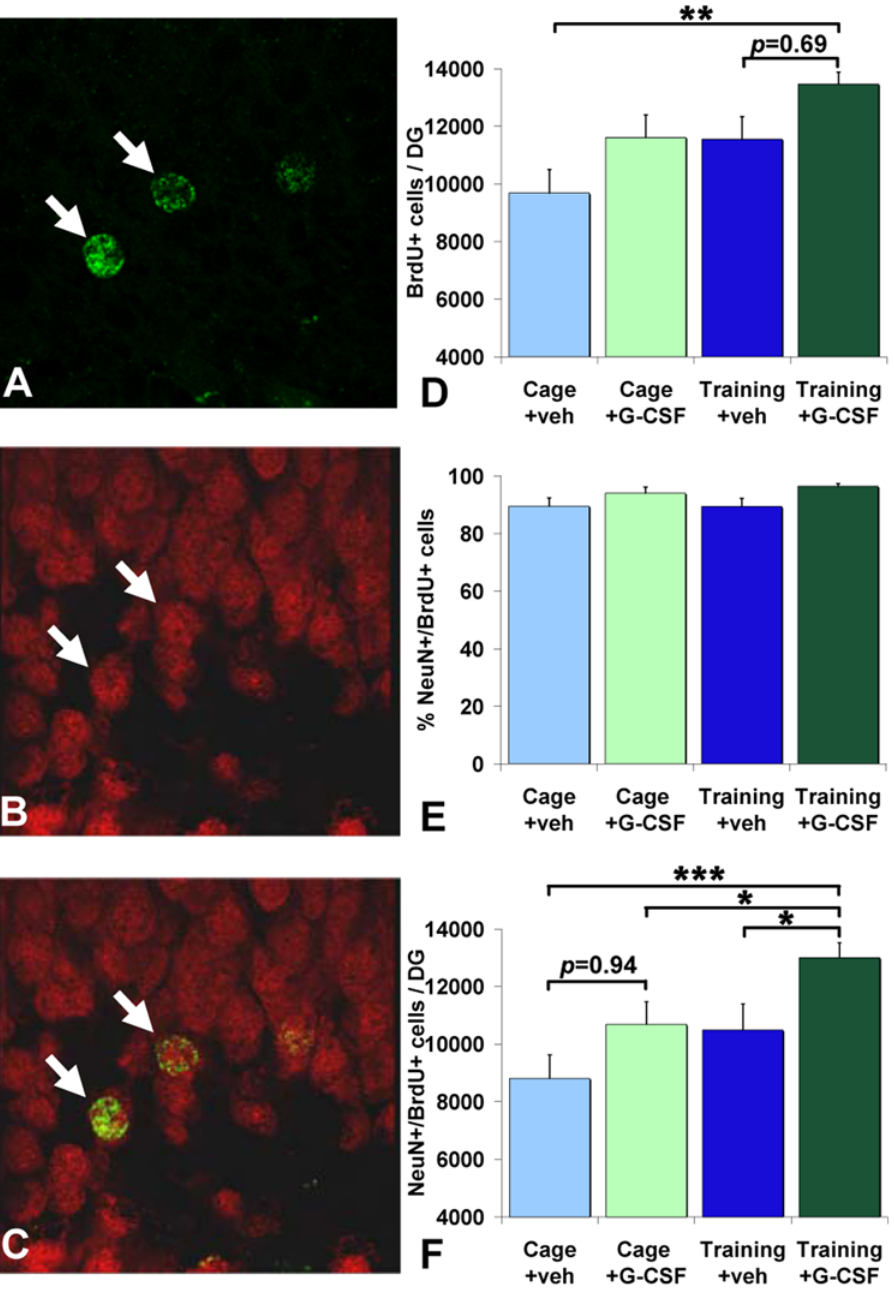
Figure 3. Quantification of neurogenesis by the detection of BrdU/NeuN-expressing cells. A–C: Confocal microscopic images immunohistochemically stained cells. A: BrdU positive cells. B: NeuN positive cells. C: merged image, BrdU/NeuN positive cells (arrows). D–F: Histograms representing the number of (D) BrdU and (F) BrdU/NeuN-expressing cells (mean 6 S.E.M.) as well as (E) the percentage of BrdU/NeuN positive cells in the dentate gyrus of vehicle and G-CSF treated rats with and without training in the radial-arm maze after the 3-day re-acquisition period. * p , 0.05; ** p , 0.01; *** p , 0.001.